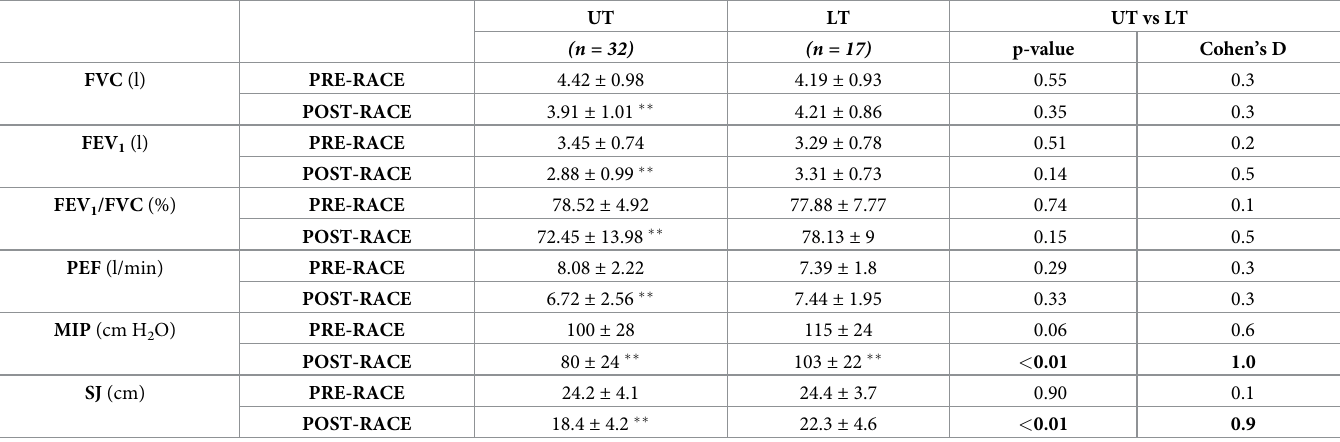
Table 2. Spirometric-derived data, maximal inspiratory pressure and squat jump at pre-race and post-race in ultra trail and long trail participants (mean ±